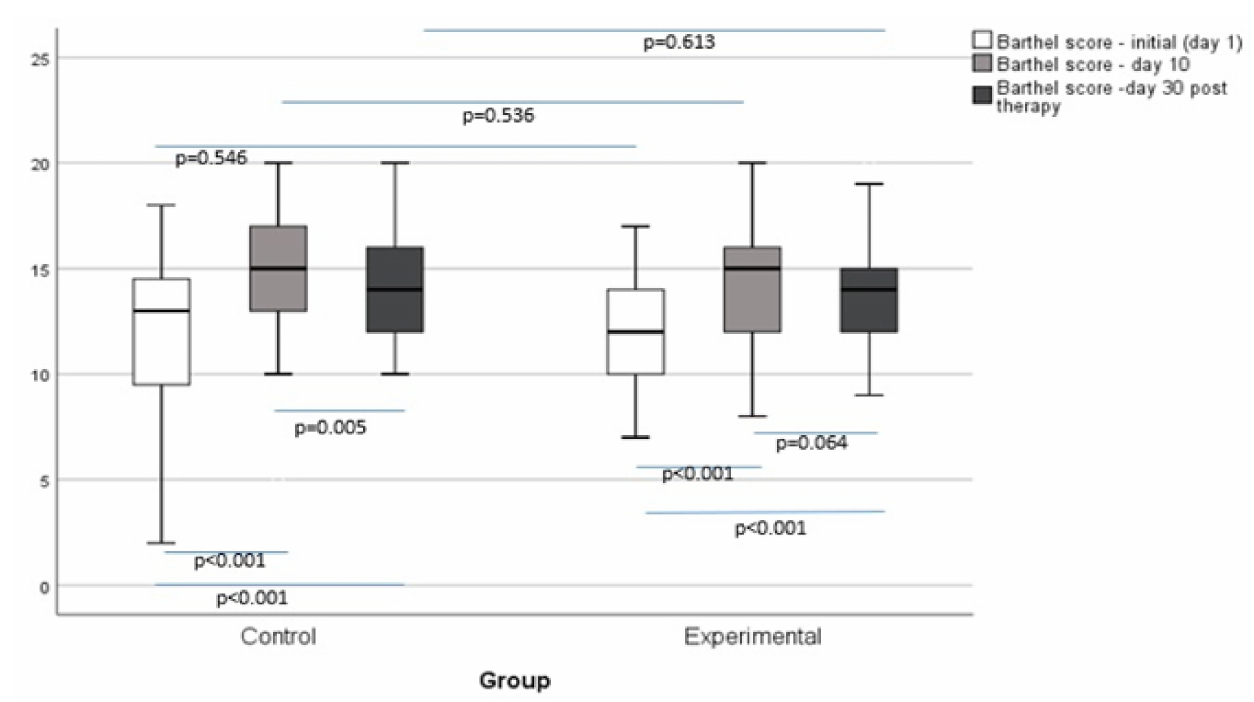
Figure 2. Barthel Score mean